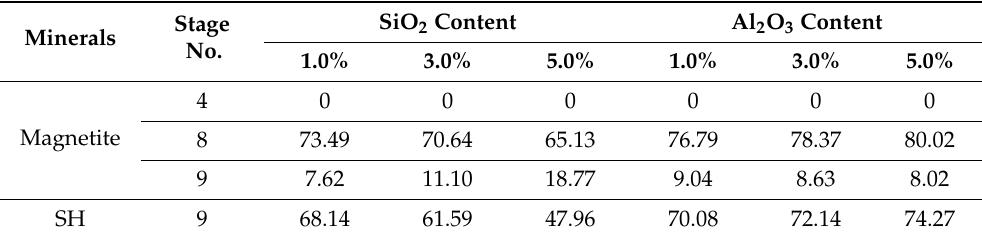
3.3. Mechanism to Hinder the SH Formation by Increase in MgO in Samples Comparing the effect of the gangue component on the formation of SH, the MgO plays a more important role than the SiO 2 and Al 2 O 3 ; therefore, we will investigate the mechanism that the SH formation was hindered with increase of MgO.